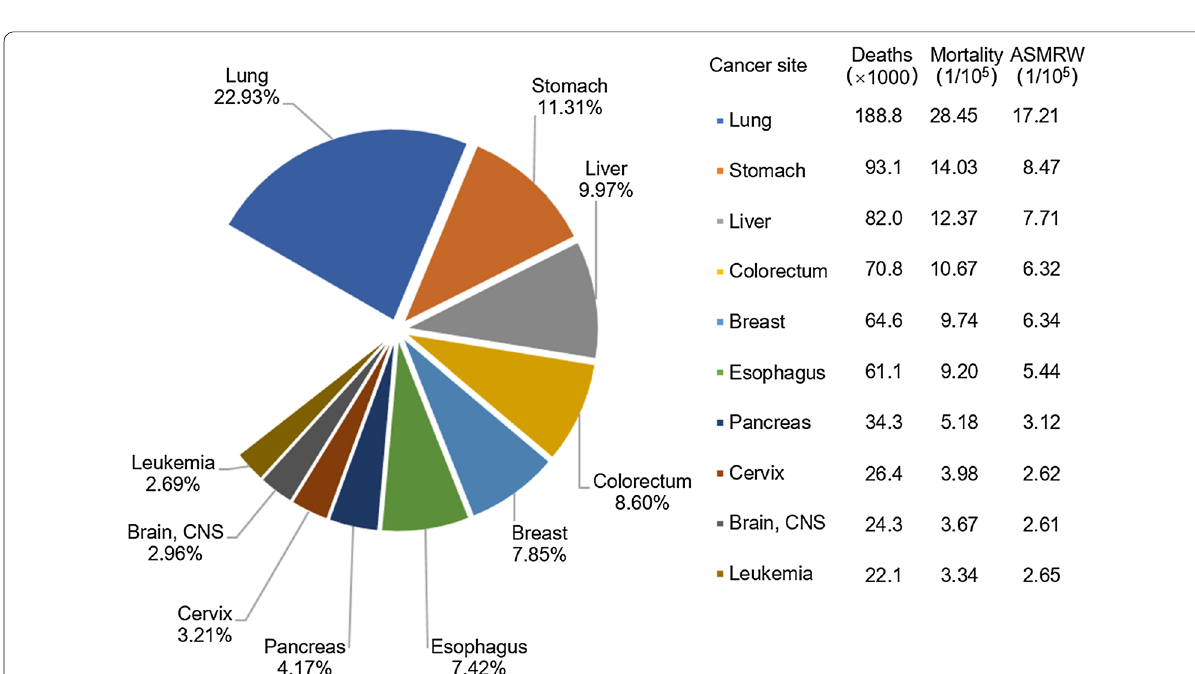
Fig. 6 Mortalities of top 10 cancers for females in China,